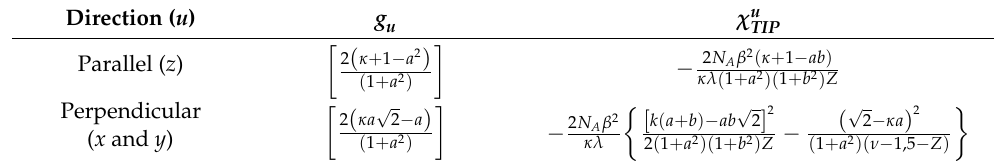
Table 2. Values of g and χ in the parallel and perpendicular directions to the magnetic fi eld. Direction ( u ) 𝒈 𝒖 𝝌 𝑻𝑰𝑷𝒖 Parallel ( z ) Perpendicular ( x and y )